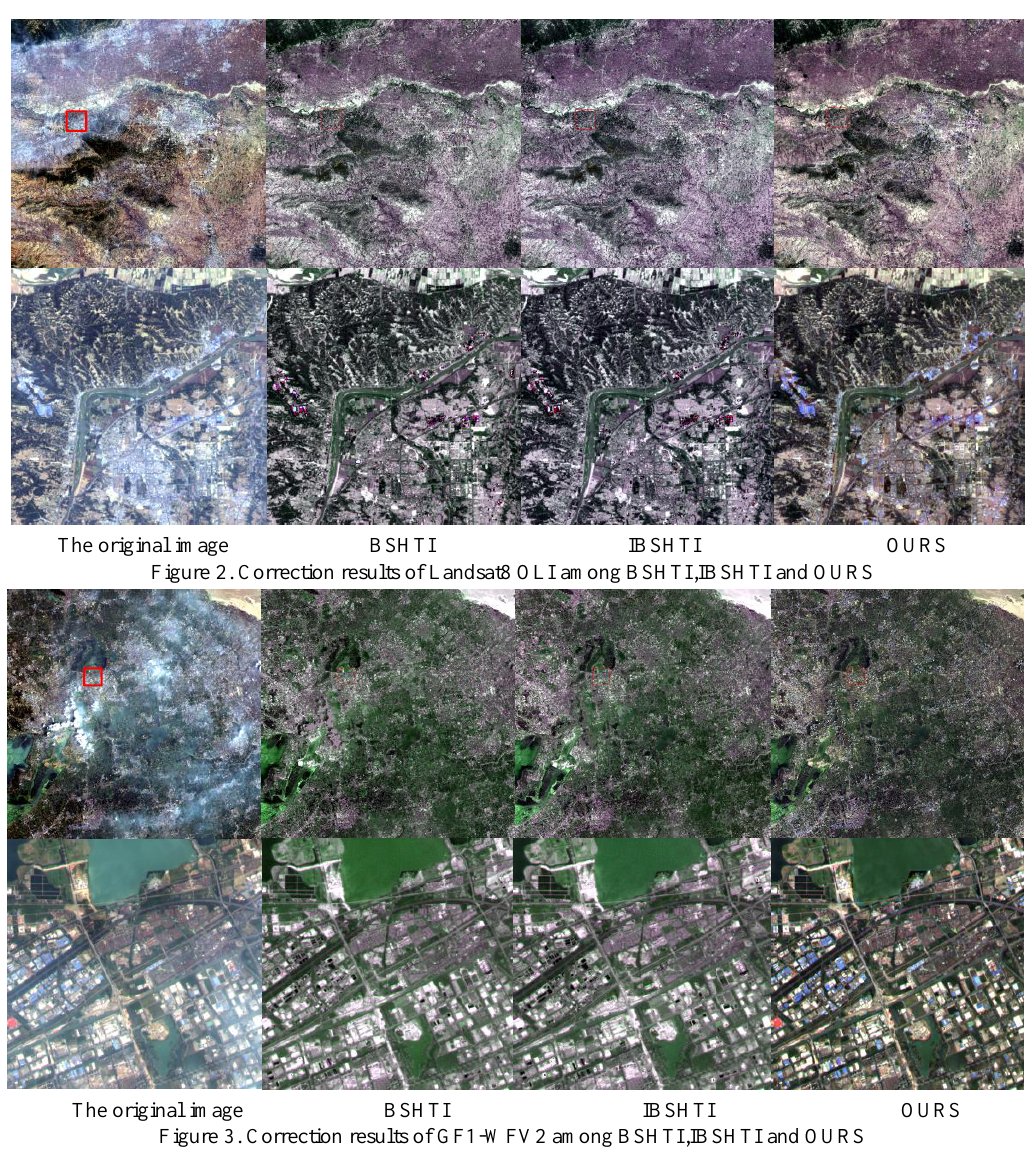
Figure 3. Correction results of GF1-WFV2 among BSHTI,IBSHTI and OURS